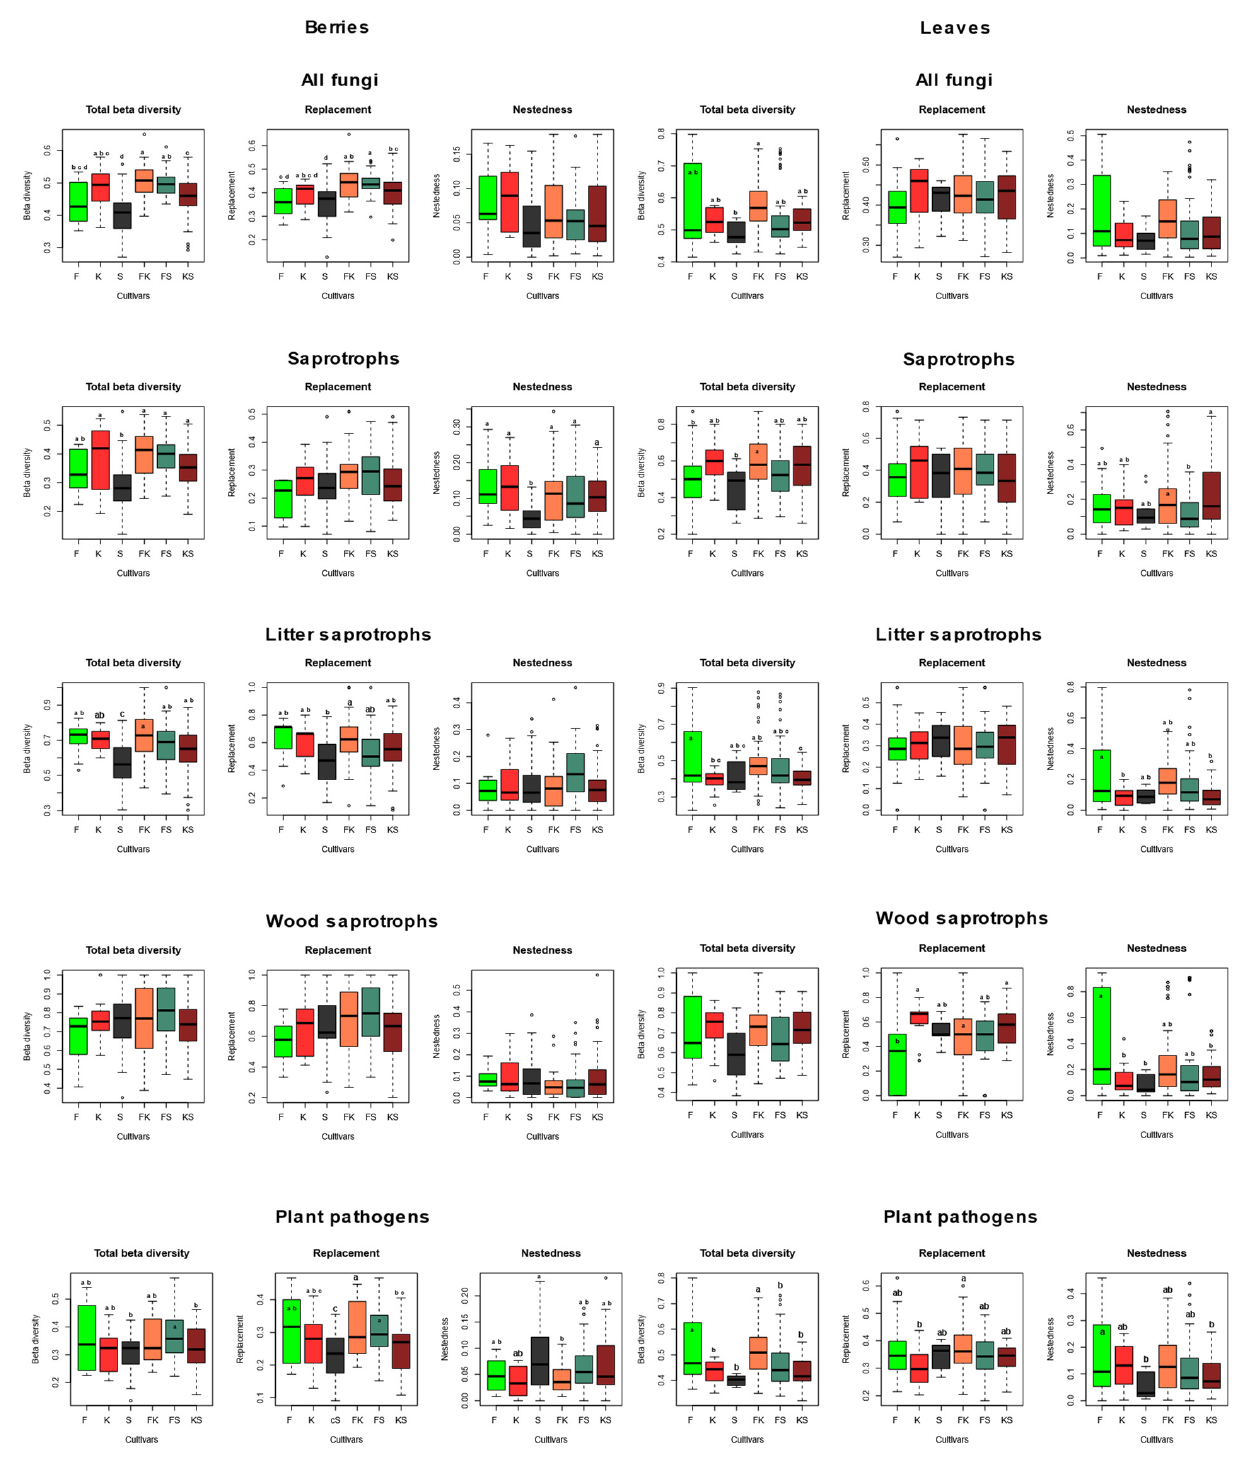
Figure 4. Boxplots showing the total beta diversity and its replacement and nestedness components in various functional groups of fungi, based on pairwise comparisons of samples within and between cultivars. Means were compared using ANOVA and Tukey’s HSD tests, with letters denoting significant differences within each boxplot. Abbreviations: F — Furmint, K — Kadarka, S — Syrah.